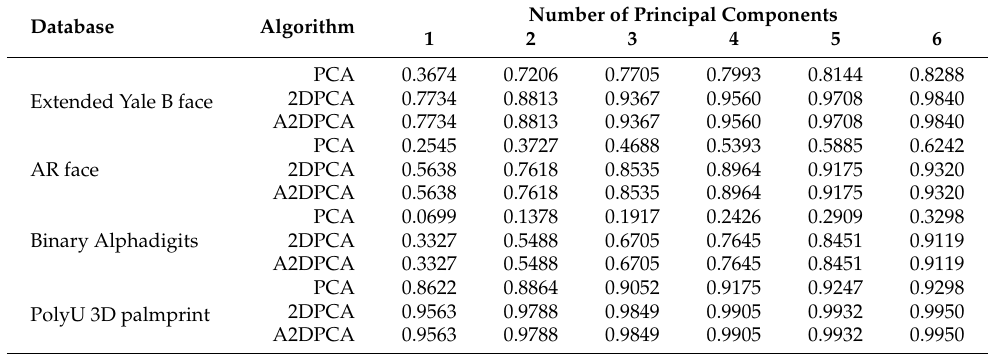
Table 4. The percentages of total variance explained by the first six principal components.